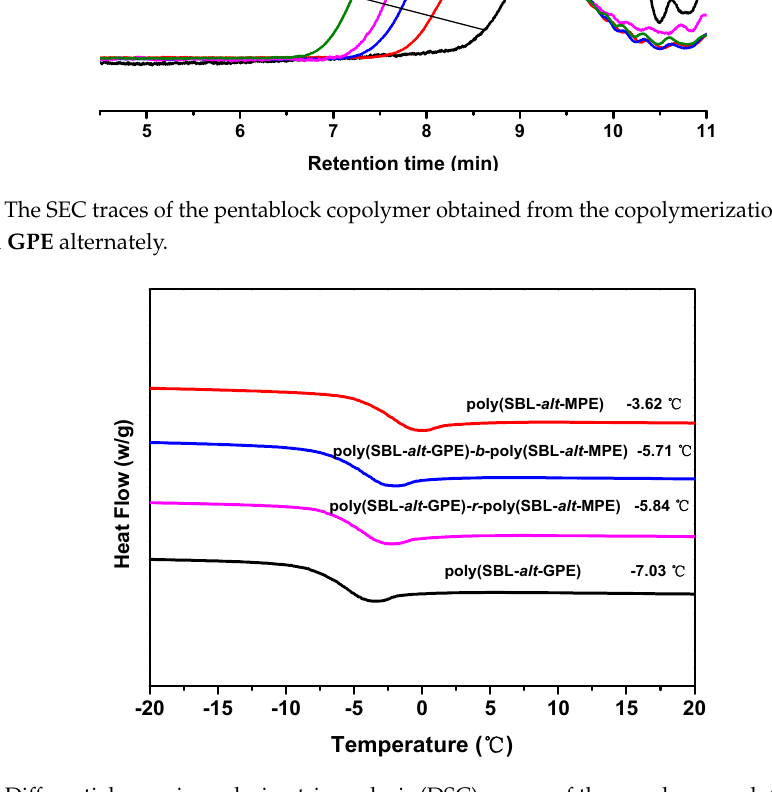
Figure 4. Differential scanning calorimetric analysis (DSC) curves of the copolymer poly( SBL - alt - GPE ) and poly( SBL - alt - MPE ), diblock copolymer poly( SBL - alt - GPE )- b -poly( SBL - alt - MPE ), and random copolymer poly( SBL - alt - GPE )- r -poly( SBL - alt - MPE